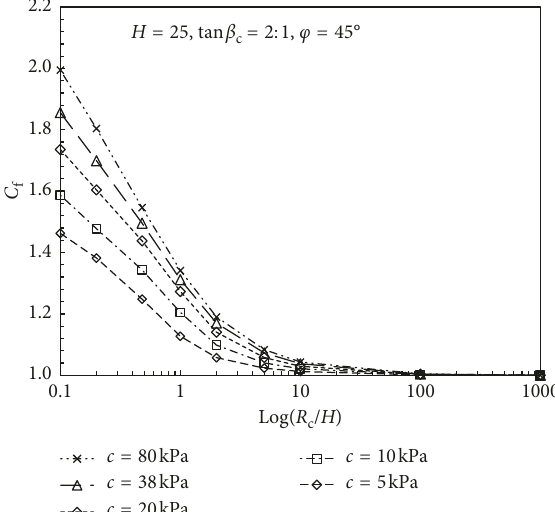
Figure 7: C f versus R c / H for different slope angles. Figure 8: C